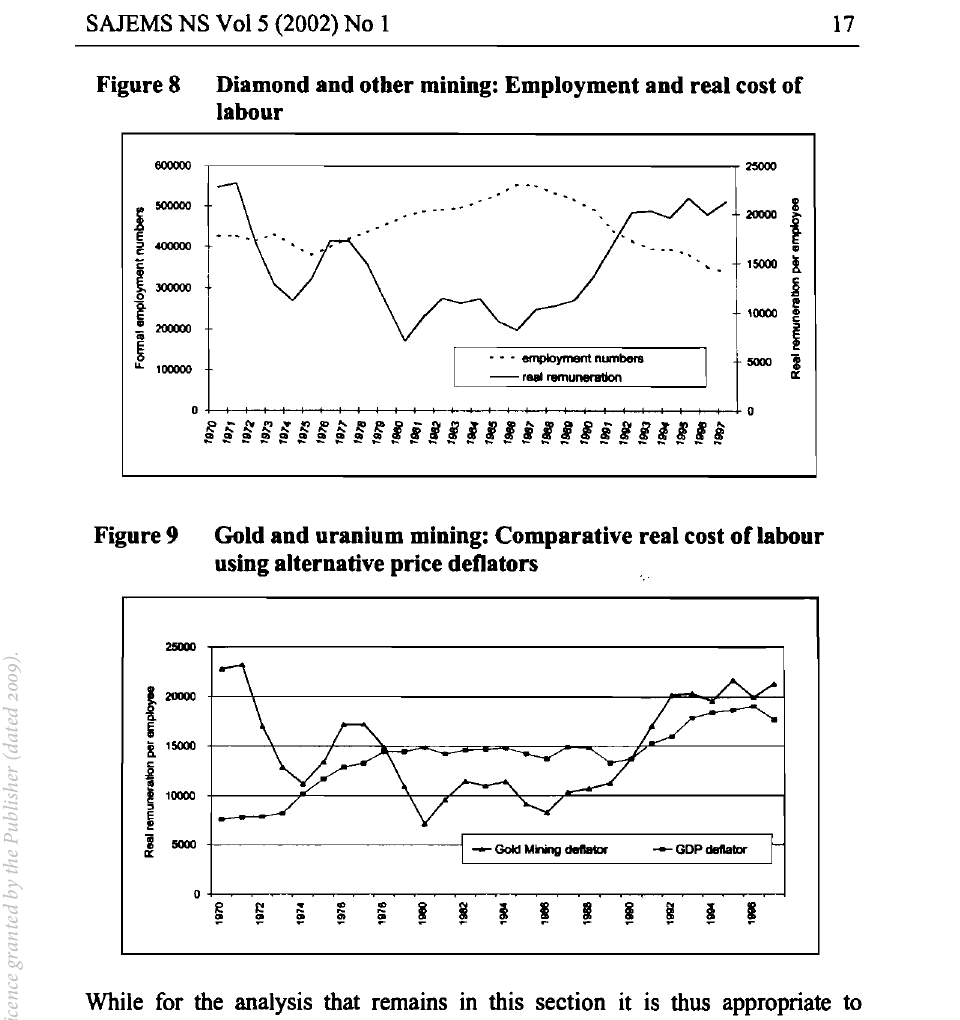
Gold and uranium mining: Comparative real cost of labour using alternative price